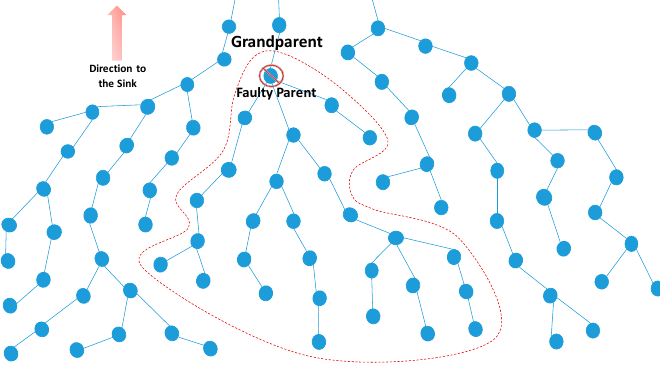
Figure 1. An example of isolation in WSN due to single parent fault.